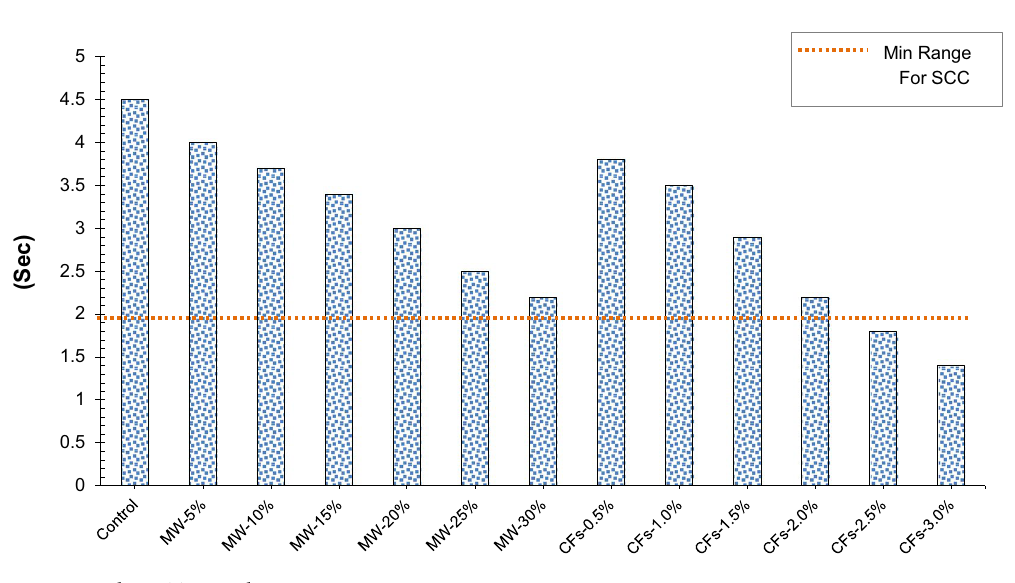
Figure 4. Slump T50